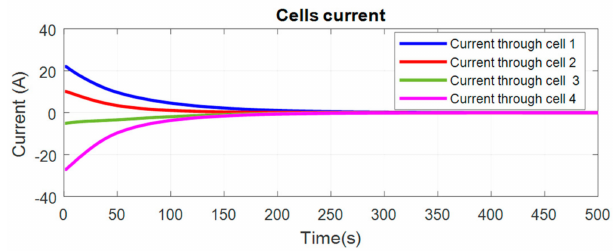
Figure 4. The currents through four cells.